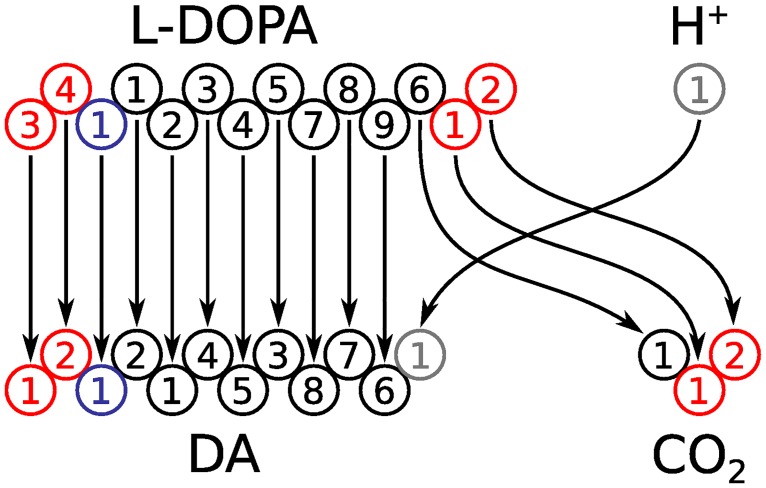
A graphical representation of an atom transition network for the DOPA decarboxylase reaction.Nodes (open circles) represent atoms. Atoms can be matched to metabolite structures in Fig 2 on their metabolite identifiers, colours and numbers. Directed edges (arrows) represent atom transitions. All except one hydrogen atom are omitted to simplify the figure.